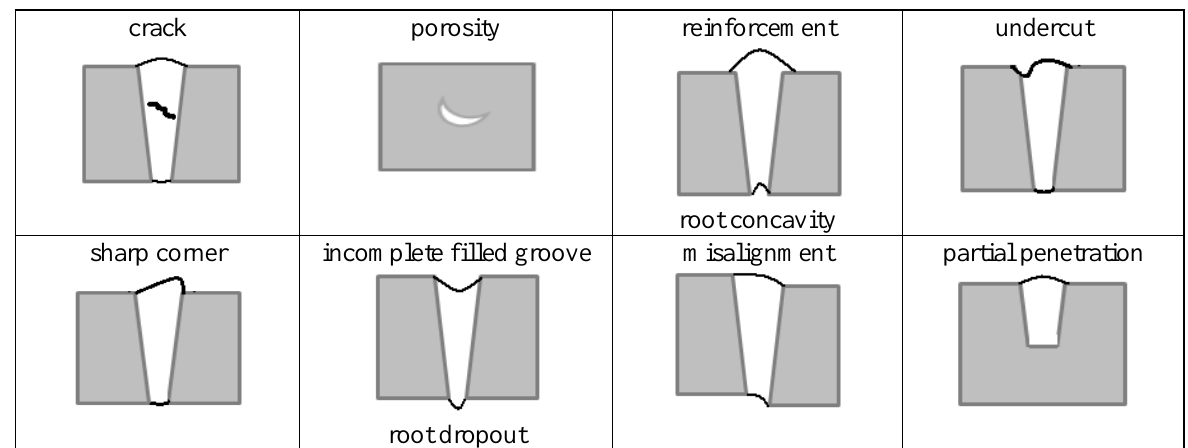
Table 1. Different types of weld defects.